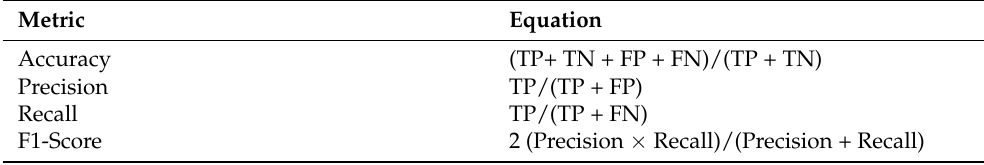
Table 3. Evaluation Metrics.